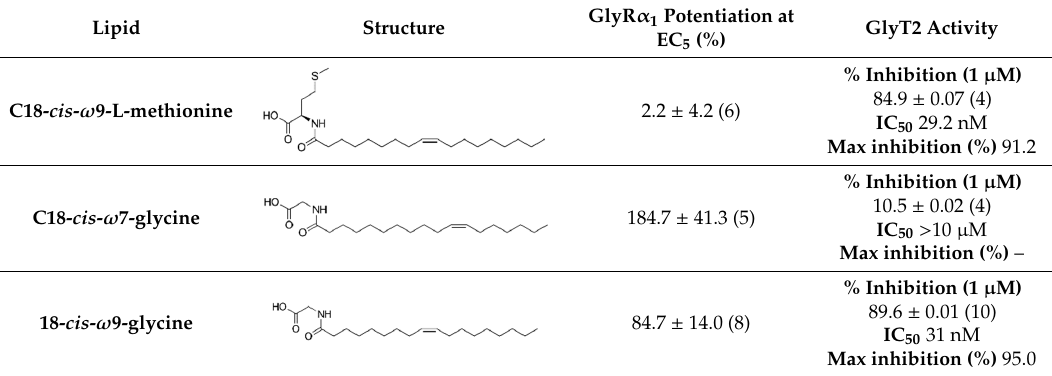
Figure 10. Activity of C18- cis - ω 9-L-methionine, C18- cis - ω 7-glycine and C18- cis - ω 9-glycine on GlyT2 and GlyR α 1 separately. ( A ) 30 µ M glycine transport currents mediated by GlyT2 were measured in the presence of lipids in a range of concentrations. Concentration-inhibition curves for C18- cis - ω 9-L-methionine, C18- cis - ω 7-glycine and C18- cis - ω 9-glycine. Normalised response in the presence of 1 µ M lipid is marked by dashed blue, green and red lines respectively. Data from [15]. ( B ) Modulation of GlyR α 1 currents at glycine EC 5 by 1 µ M C18- cis - ω 9-L-methionine, C18- cis - ω 7-glycine and C18- cis - ω 9-glycine were previously measured. ( C ) Example traces of GlyR α 1 modulation by lipids . Currents were normalised to I max and fit to the Hill equation. Symbols are mean ± SEM ( n ≥ 3). Data from [18].